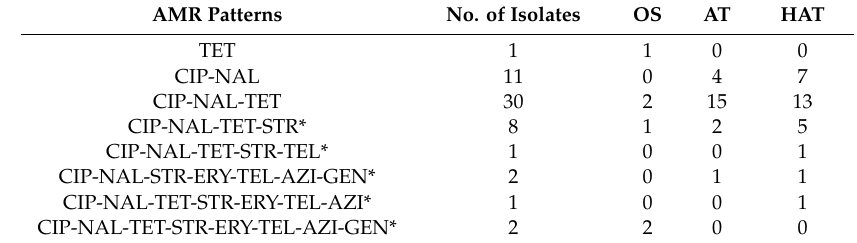
Table 3. Antimicrobial resistance (AMR) patterns according to aerotolerance levels in C. coli